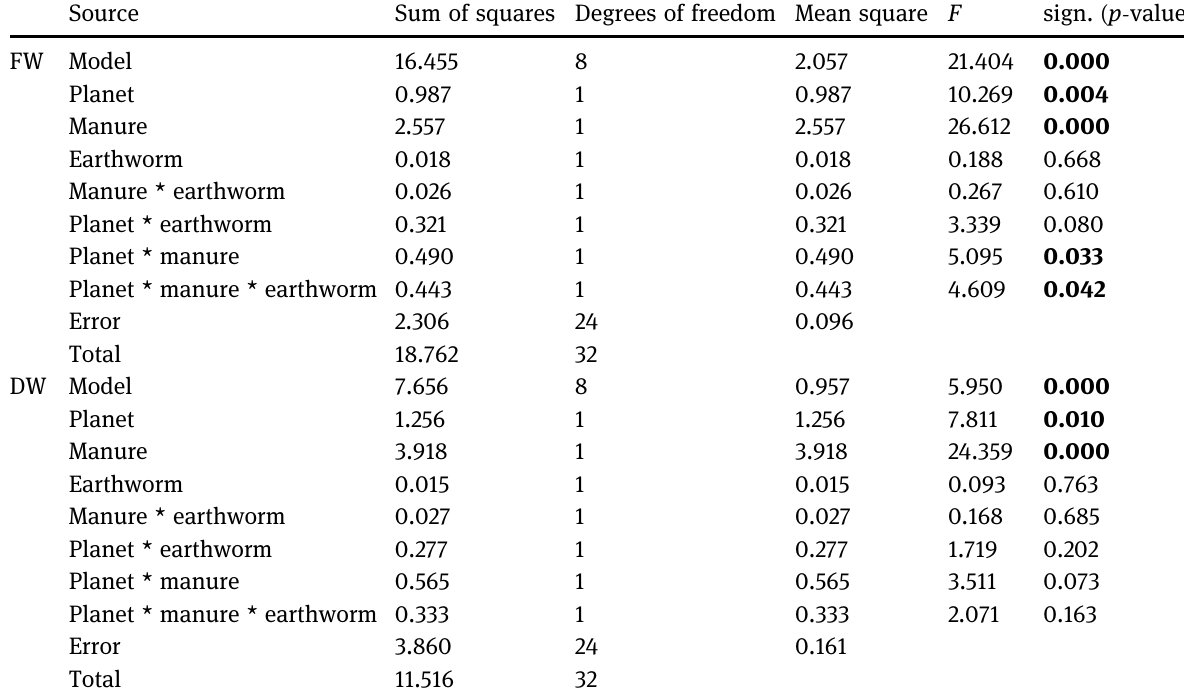
Table 4: Results of the 3 - way - ANOVA for FW and DW for all treatments and interactions.